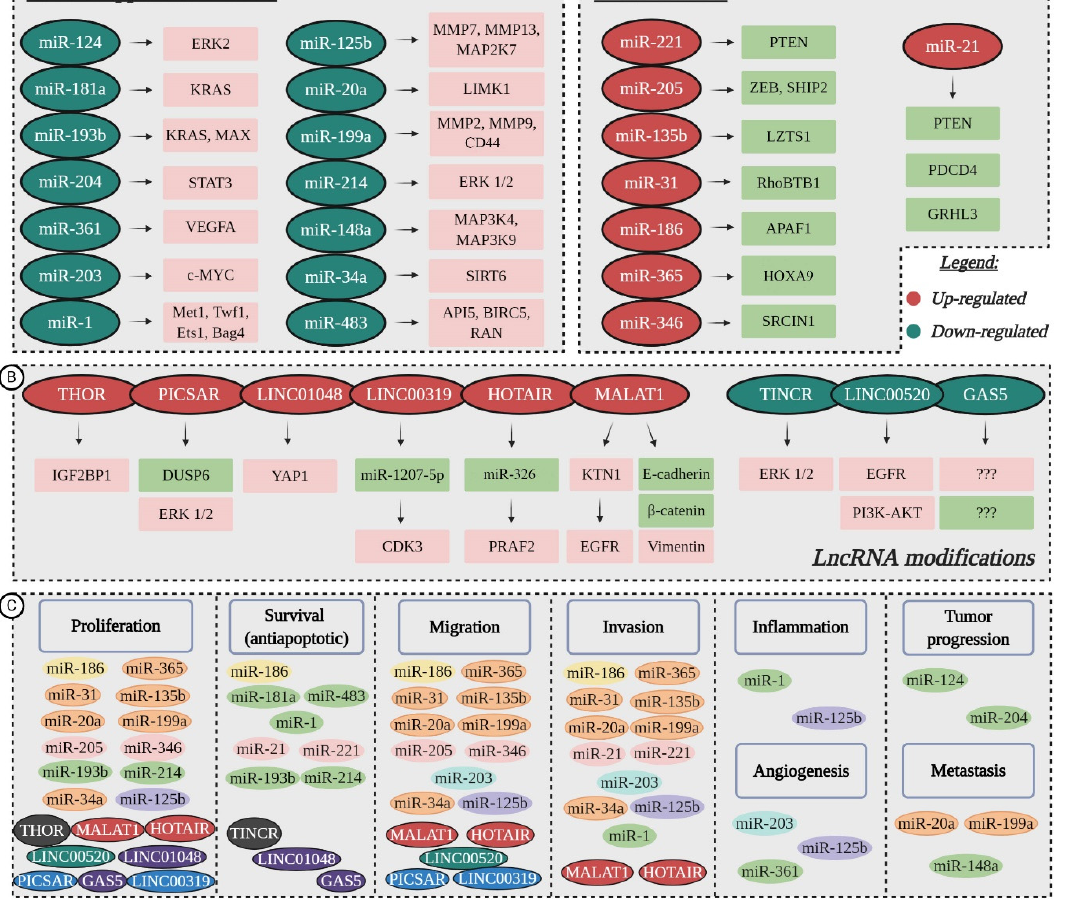
Figure 3. Non-coding RNA modifications and their functional roles in cSCC development: ( A ) down-regulation of tumor suppressor microRNAs (miRNAs) leads to the overexpression of target genes, while up-regulation of onco-miRNAs has a suppressive effect on specific molecular targets; ( B ) Dysregulated long non-coding RNAs (lncRNAs) that contribute to tumor progression through abnormal regulation of targeted genes (currently unknown for GAS5); ( C ) LncRNAs and miRNAs favor cell proliferation, survival, migration, invasion, inflammation, angiogenesis, tumor progression and metastasis in cSCC. Color-coded for involvement in several processes (created in BioRender.com).